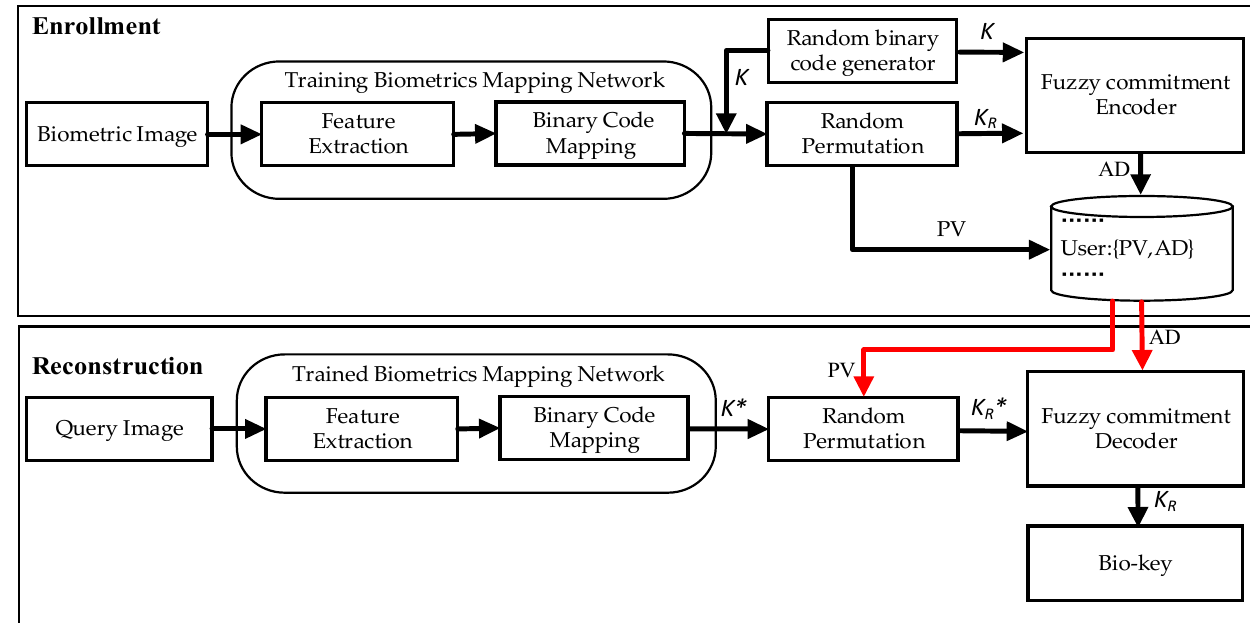
Figure 2. An overview of our proposed bio-key generation mechanism. (1) Enrollment stage: a pair of generated PV and AD are stored in database for each user; (2) Reconstruction stage: the final bio-key is recovered with the helper data of the PV and AD.